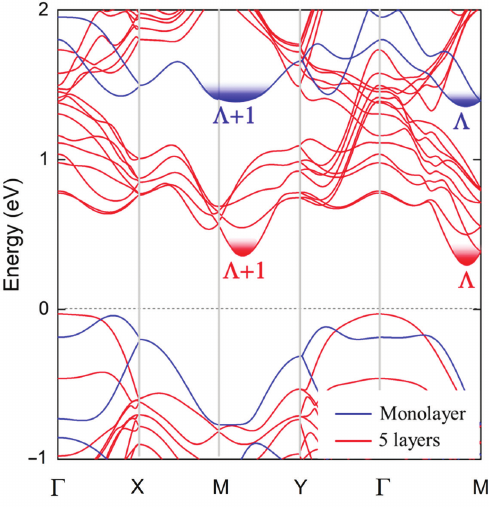
Figure 4: Comparison of the electronic band structure of monolayer and five-layer PdSe calculated by first-principles 2